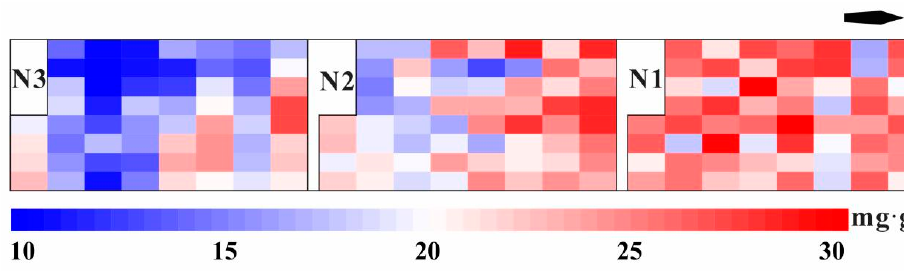
Figure 8. Map of optimum TNC. Table 6. t-test under different nitrogen